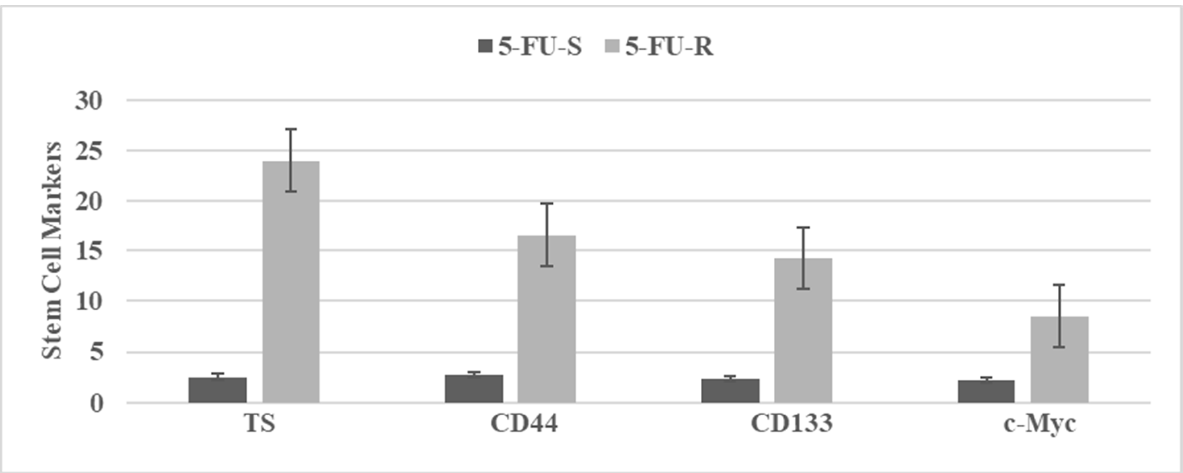
Figure 3. The status of stem cell markers in 5-fluoro-uracil resistant (5-FU-R) Mlh 1 /1638N COL phenotype. Figure 3. TS: tumor spheroid number determined at day 14 after seeding 100 cells. Data expressed as Mean ± SD, n = 3 per treatment group. CD44, CD133 c-Myc. RFU determined at day four after seeding 1.0 × 10 5 cells. Data expressed as Mean ± SD, n = 3 per treatment group. Data analyzed by paired Student’s t -test. 5-FU-S, 5-fluoro-uracil sensitive; 5-FU-R, 5-fluoro-uracil resistant; CD, cluster of differentiation; c-Myc, cellular Myc; RFU, relative fluorescent unit. Data summarized from [22].